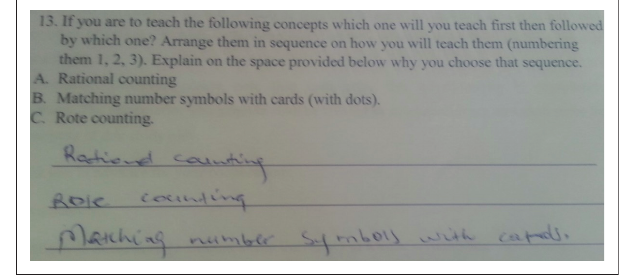
FIGURE 14: Response showing poor sequencing of